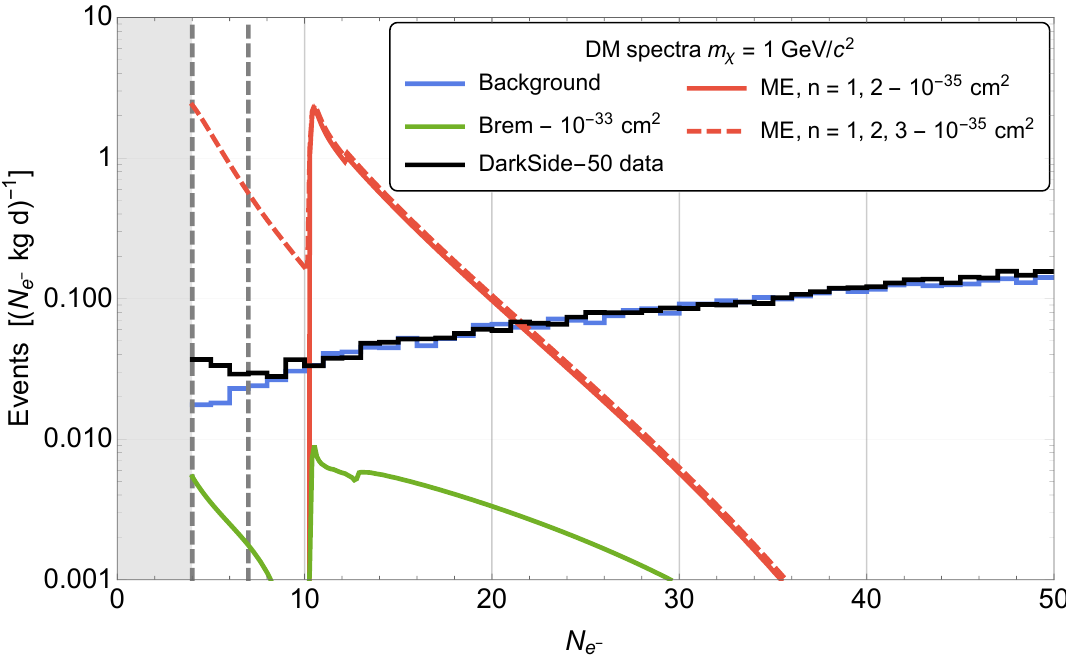
Figure 2 . Number of events per kg per day for the Migdal effect signal for m (cid:31) = 1 GeV/ c 2 and (cid:27) SI = 10 (cid:0) 35 cm 2 , for n = 1 ; 2 ; 3 (red dashed) and n = 1 ; 2 (solid red). The green curve shows the number of events for the photon Bremsstrahlung signal for a DM mass of 1 GeV/ c 2 and (cid:27) SI = 10 (cid:0) 33 cm 2 . The histograms show the DarkSide-50 spectrum (black) and background (blue) for an exposure E = 6786 kg d